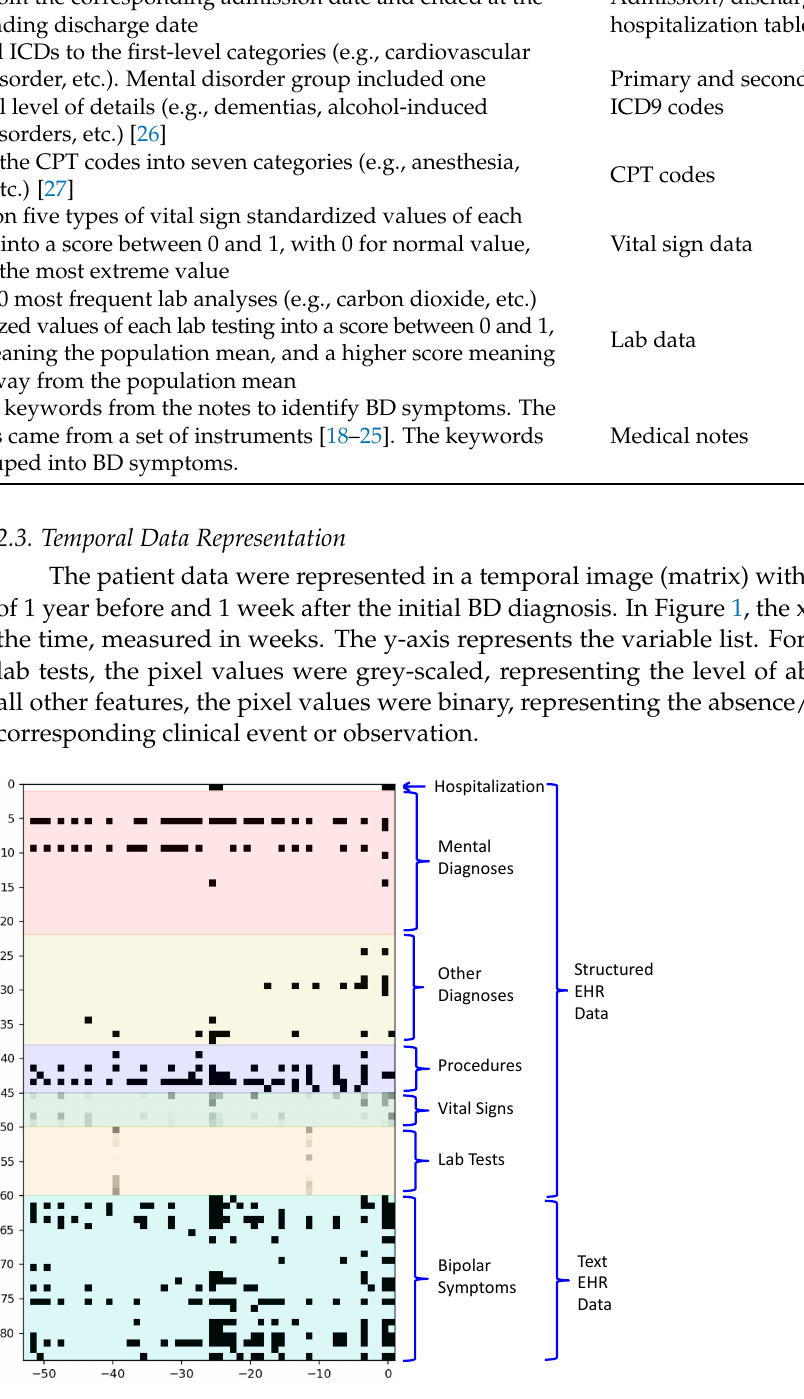
Figure 1. An example of a temporal image for an individual patient.